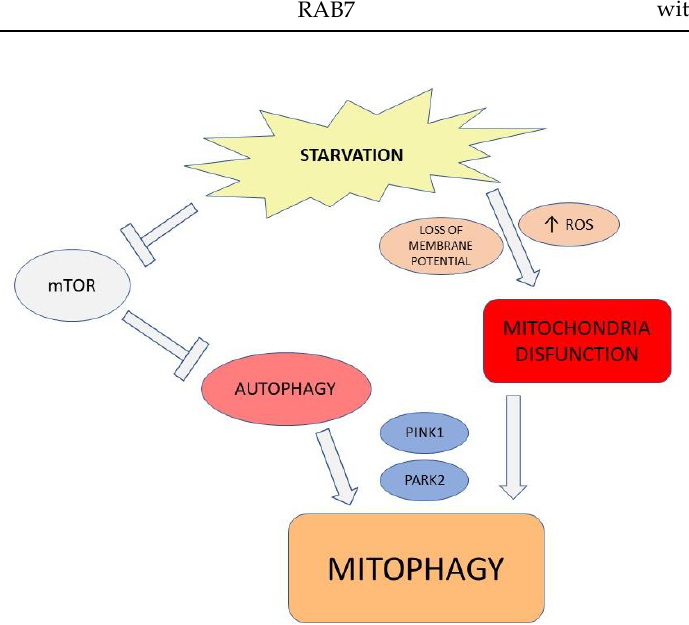
Figure 1. Metabolic activity and mitophagy. Decrease in energetic supply inhibits mTOR activity, which enhances autophagy. The energetic starvation leads to the loss of mitochondria membrane potential, associated to ROS overproduction. This condition activates PTEN-induced putative kinase 1 (PINK1) and the E3 ligase parkin (PARK2), which is able to ubiquitylate mitochondrial outer membrane proteins, providing recognition signals to the active autophagy machinery.